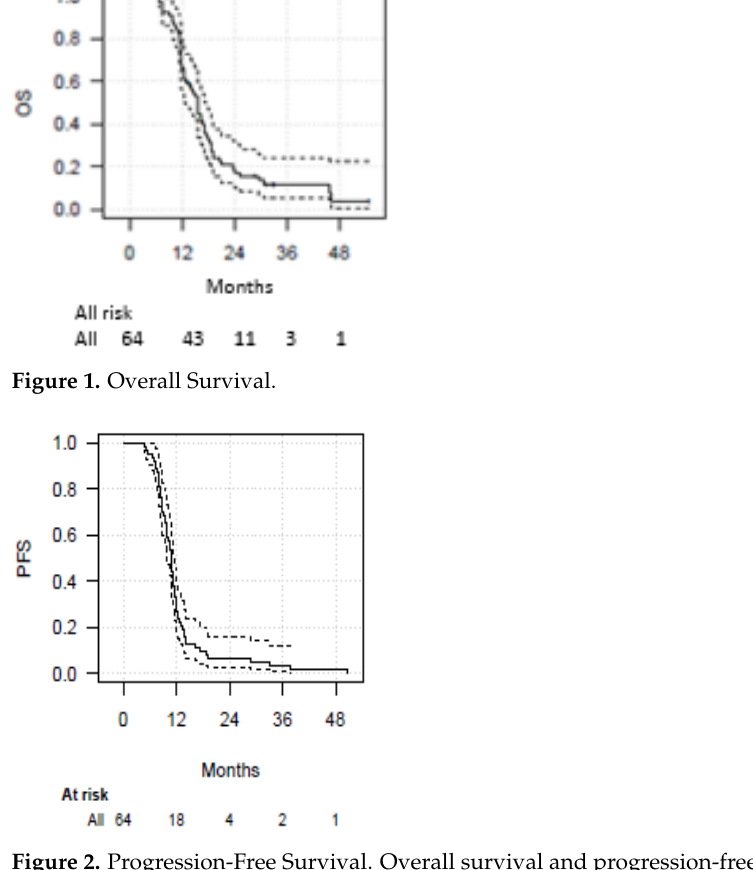
Figure 2. Progression-Free Survival. Overall survival and progression-free survival Kaplan–Meier curves (solid line), with 95% confidence interval (dashed line). Table 2. Acute radiotherapy-related toxicity, according to CTCAE